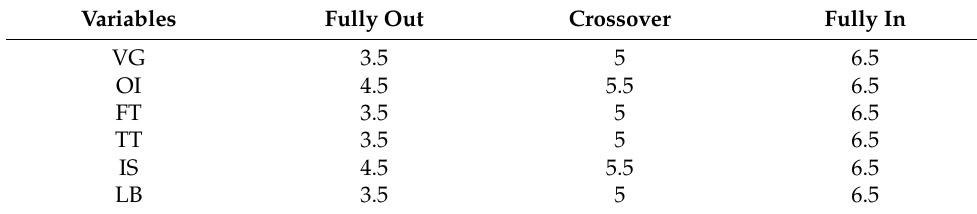
Table 3. Each variable’s calibration anchors.